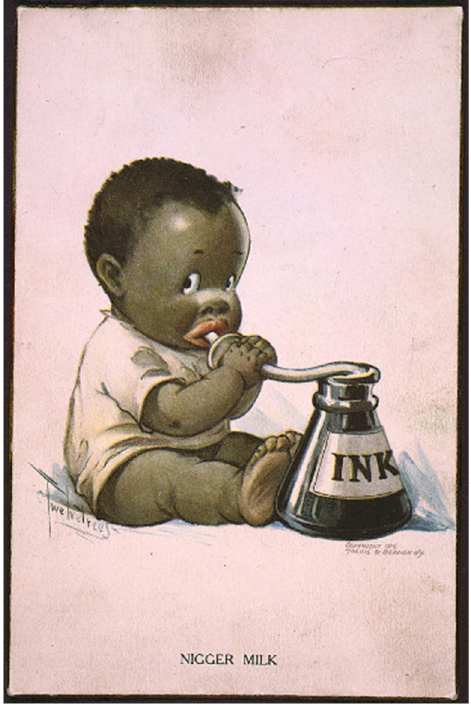
Figure 1. Charles Twelvetrees, “N***** MILK,” c. 1916 (Getty Images 2021).